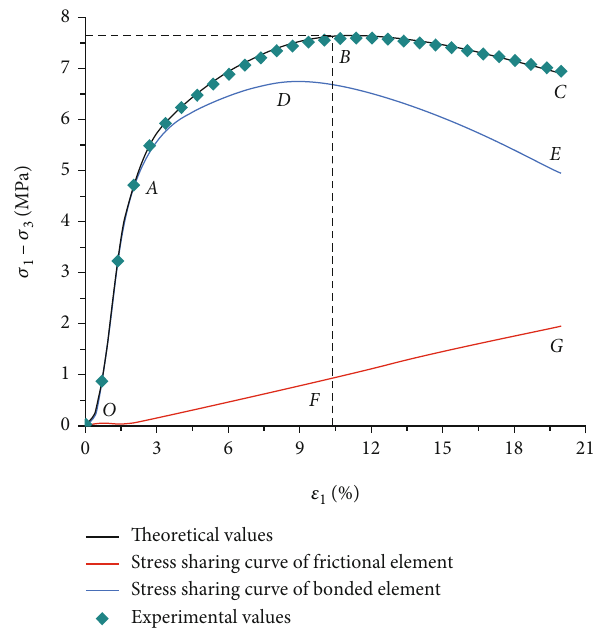
Figure 10: Comparison between theoretical values and the experimental values (FPC-1 under 0.2 MPa con fi ning